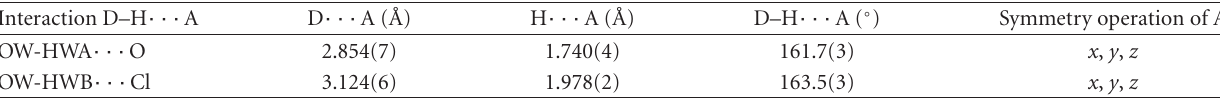
Table 3: Hydrogen bonding interactions in 1 · 2H 2 O.